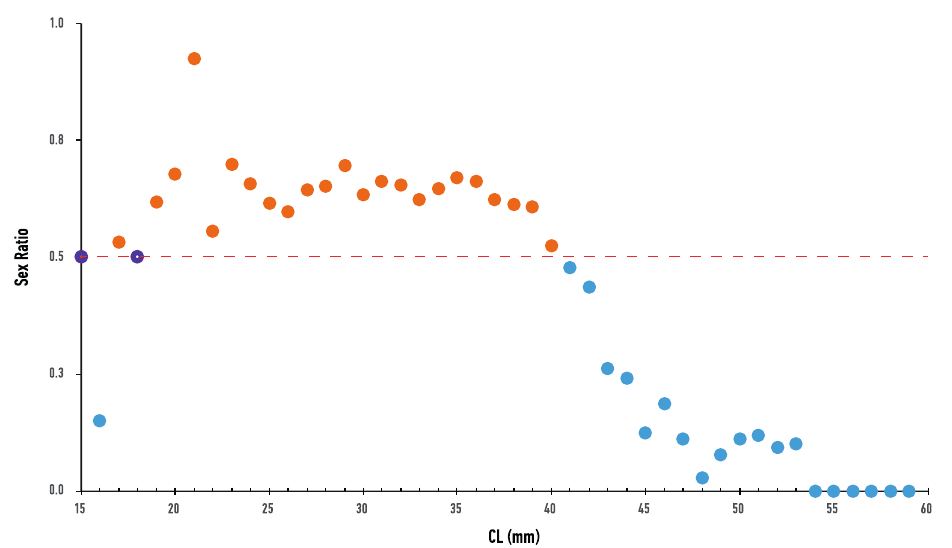
Figure 4. Sex ratio, in terms of the proportion of female Nephrops individuals, for each size class. Dashed line indicates the 1:1 equilibrium. Dots over the dashed line indicate female dominance, whereas dots under the dashed line indicate male dominance, for the specific size class.